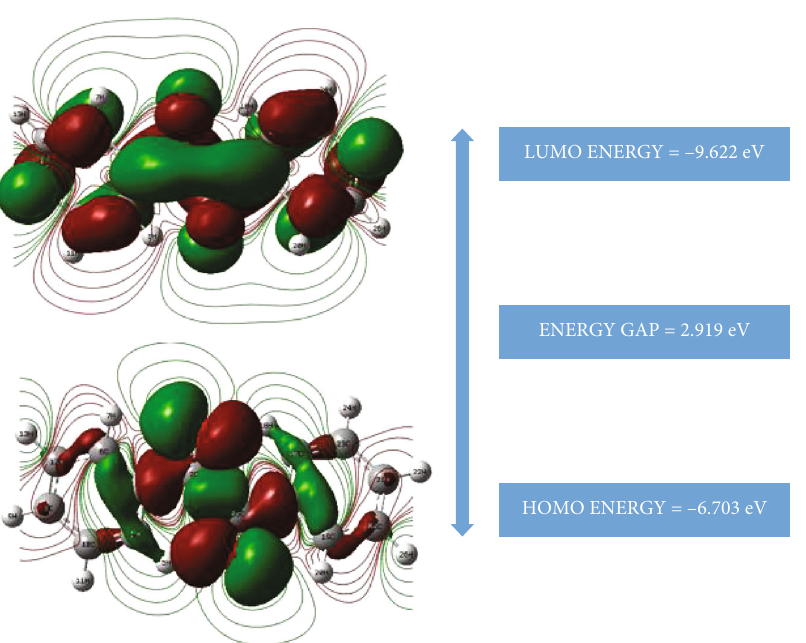
Figure 5: HOMO-LUMO plot of